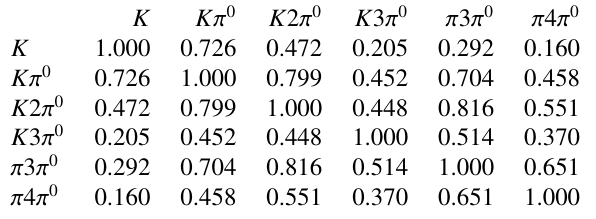
Table 4. Total correlation matrix for the branching fractions of the signal modes